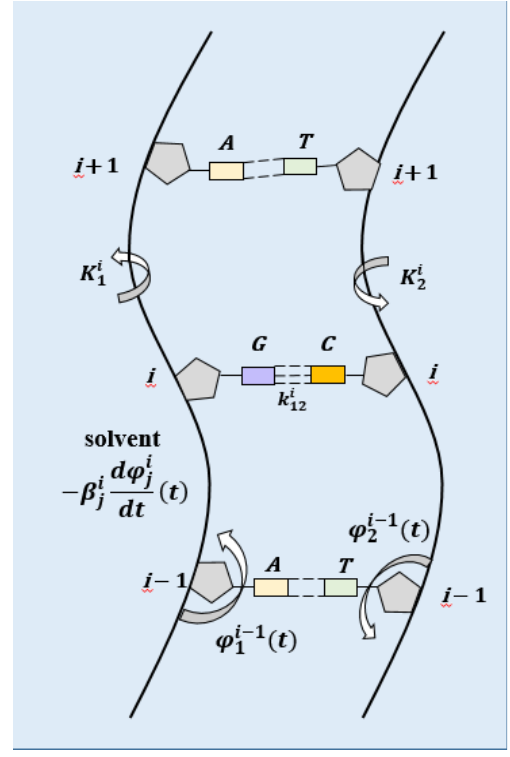
Figure 1. Graphic illustration of the model.